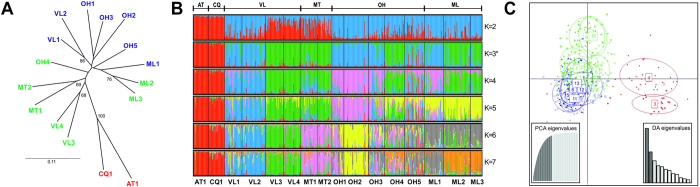
Genetic clustering of Ps. viburni populations from Chile.Results obtained using (A) Distance-based neighbor-joining tree, with node support obtained using 1,000 bootstrap replicates over loci (cut-off value >65); (B) Bayesian clustering method implemented in STRUCTURE; (C) Discriminant analysis of principal components (DAPC). Populations have been color-coded in figures 2A and 2C following the clusters obtained from STRUCTURE.